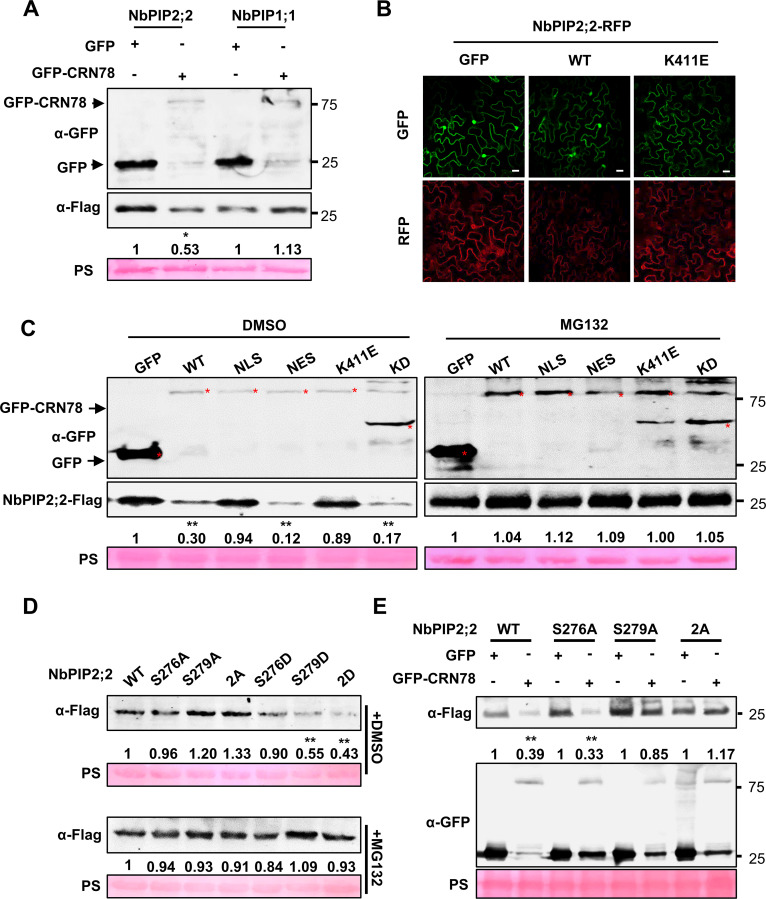
CRN78-mediated phosphorylation of NbPIP2;2 at Ser279 induces the degradation of NbPIP2;2.WT: GFP-CRN78WT; NLS: GFP-CRN78NLS; NES: GFP-CRN78NES; K411E: GFP-CRN78K411E; KD: GFP-CRN78KD. (A) Degradation of NbPIP2;2 by CRN78 in vivo.
GFP-CRN78 or GFP together with Flag-labeled NbPIP2;2 or NbPIP1;1 were transiently co-expressed in N. benthamiana leaves, and protein levels were analyzed by immunoblotting. Numbers below the blots represent the relative abundance of NbPIP2;2-Flag or NbPIP1;1-Flag. Ponceau staining was used to show equal loading. (B) Live cell image assay. Confocal microscopy images were taken at 48 hours post infiltration. (C) Membrane localization and the kinase domain is important for CRN78 to reduce NbPIP2;2 abundance. Protein levels under DMSO (left) or MG132 (right) treatment were analyzed by western blotting at 48 hours post infiltration. Ponceau staining was used to show equal loading. Numbers below the blots represent the relative abundance of NbPIP2;2-Flag. (D) Degradation of NbPIP2;2 by phosphorylation at Ser279 in vivo. Numbers below the blots represent the relative abundance of NbPIP2;2-Flag. Ponceau staining was used to show equal loading. Protein levels under DMSO (upper) or MG132 (below) treatment was shown by immunoblotting (E) Protein accumulation levels of NbPIP2;2 mutants in the presence of CRN78. Protein levels were analyzed by western blotting at 48 hours post infiltration. Ponceau staining was used to show equal loading. Numbers below the blots represent the relative abundance of NbPIP2;2-Flag.